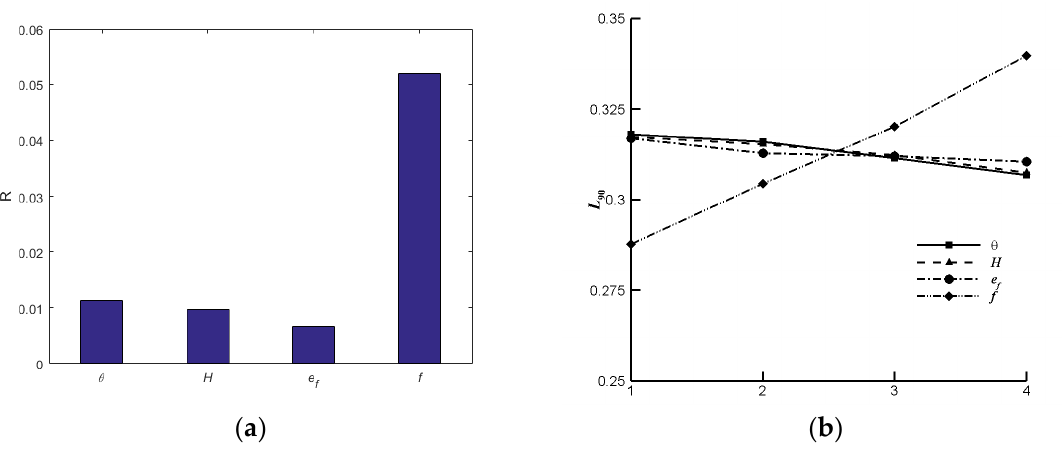
Figure 14. Range and impact of various parameters on L 90 . ( a ) Range. ( b ) Influence trend.